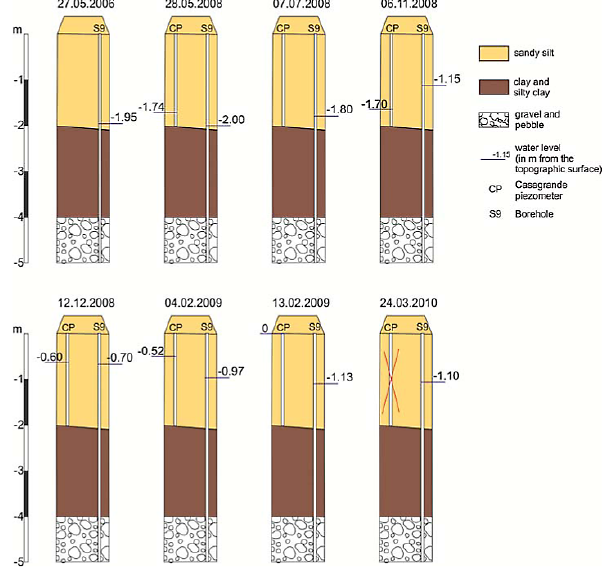
Fig. 5. Comparison between the piezometric levels observed in the perched aquifer and in the confined aquifer. On 24.03.2010 the Casagrande piezometer was